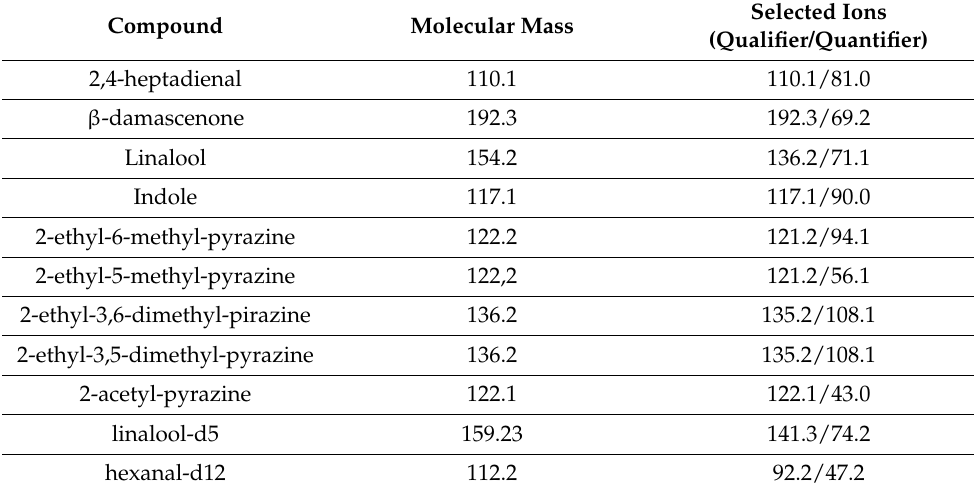
Table 1. VFC names, molecular mass and qualifier and quantifier ions selected for quantitative analysis in SIM